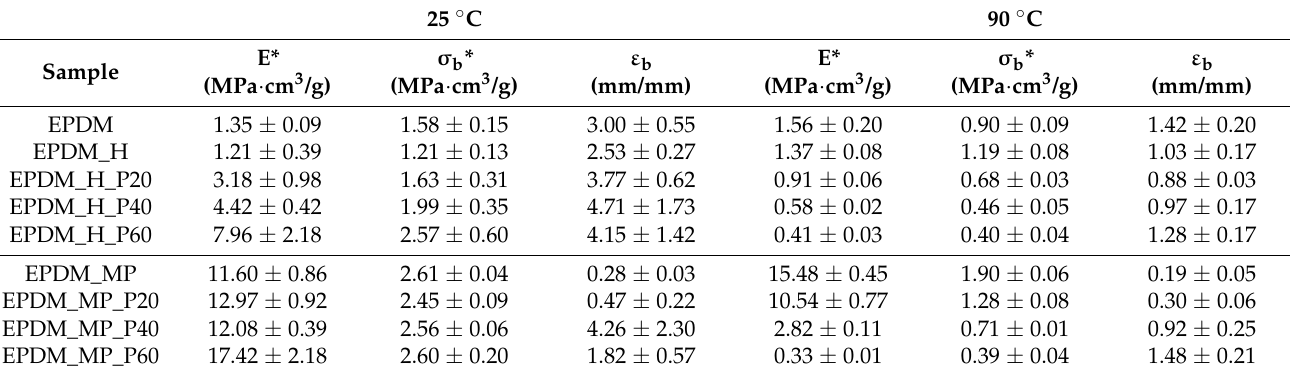
Figure 8. Representative tensile stress-strain curves at 25 °C and 90 °C of bulk EPDM sample and foams produced with ( a , c ) H and ( b , d ) MP foaming agents. Table 8. Results of quasi-static tensile tests at 25 °C on the prepared samples.